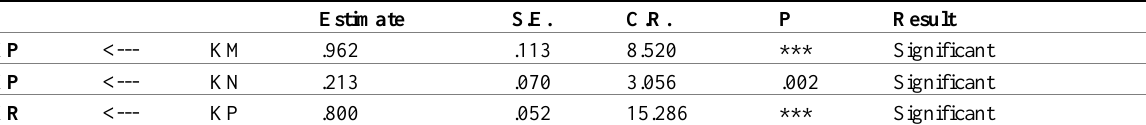
Figure 2: Final Model After Modification Table 4: Regression